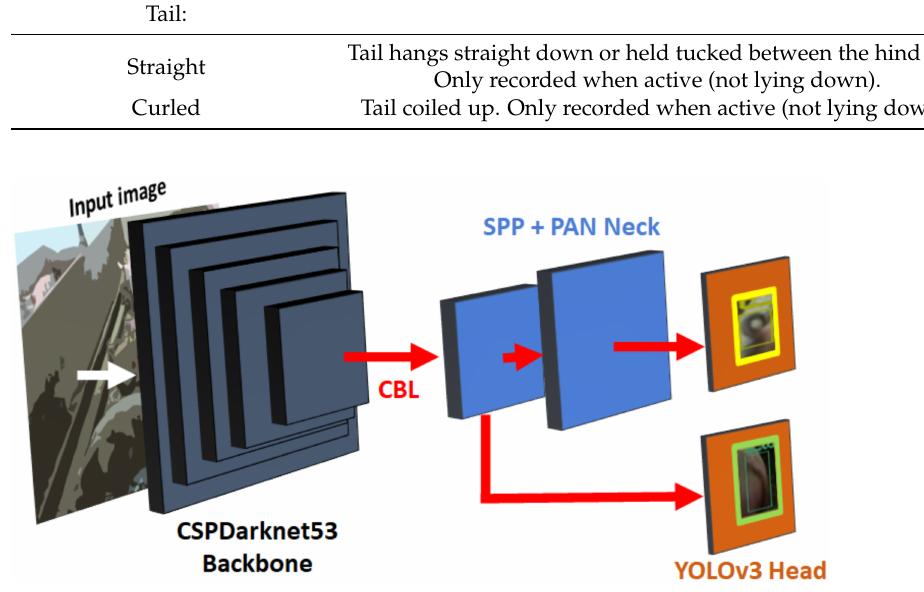
Figure 6. YOLOv4 object